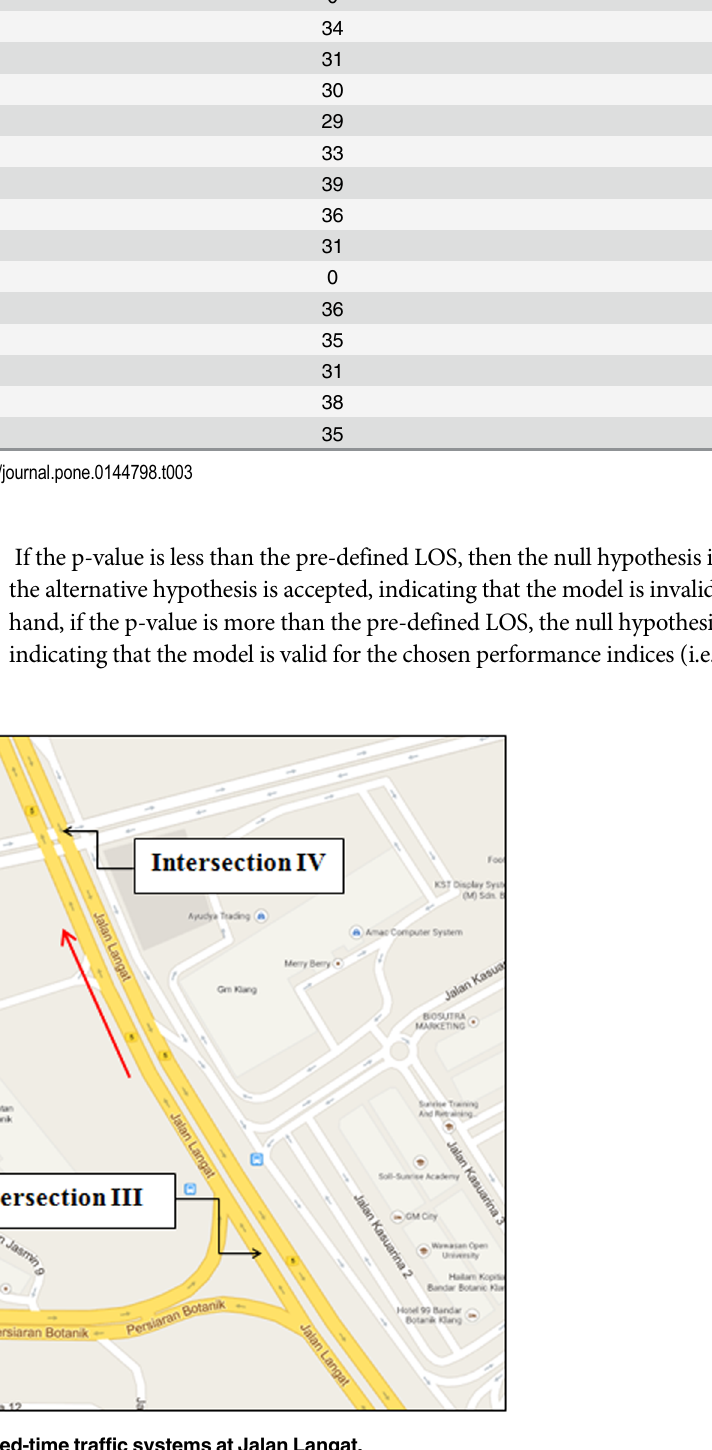
Fig 8. Fixed-time traffic systems at Jalan